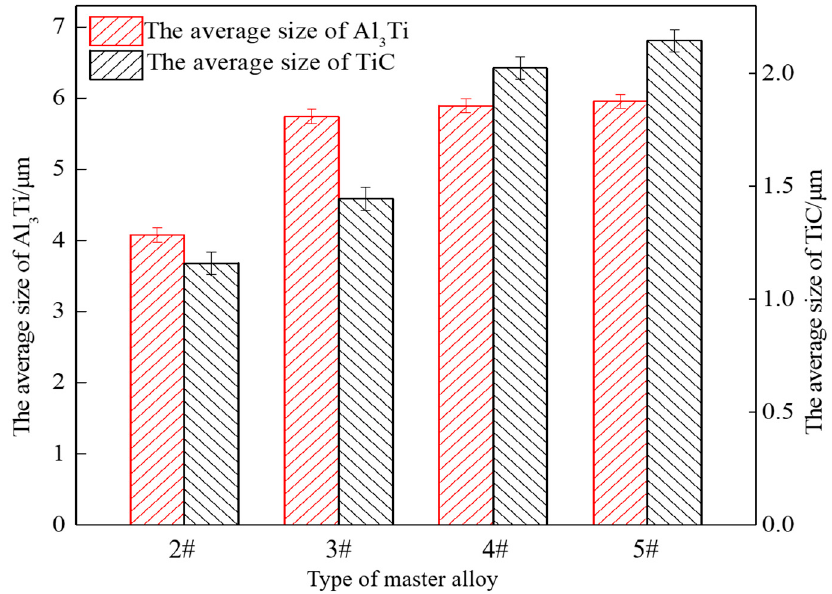
Figure 7. The statistics chart of the second phase particles in prefabricated block with different CeO 2 size under complete reaction. size under complete